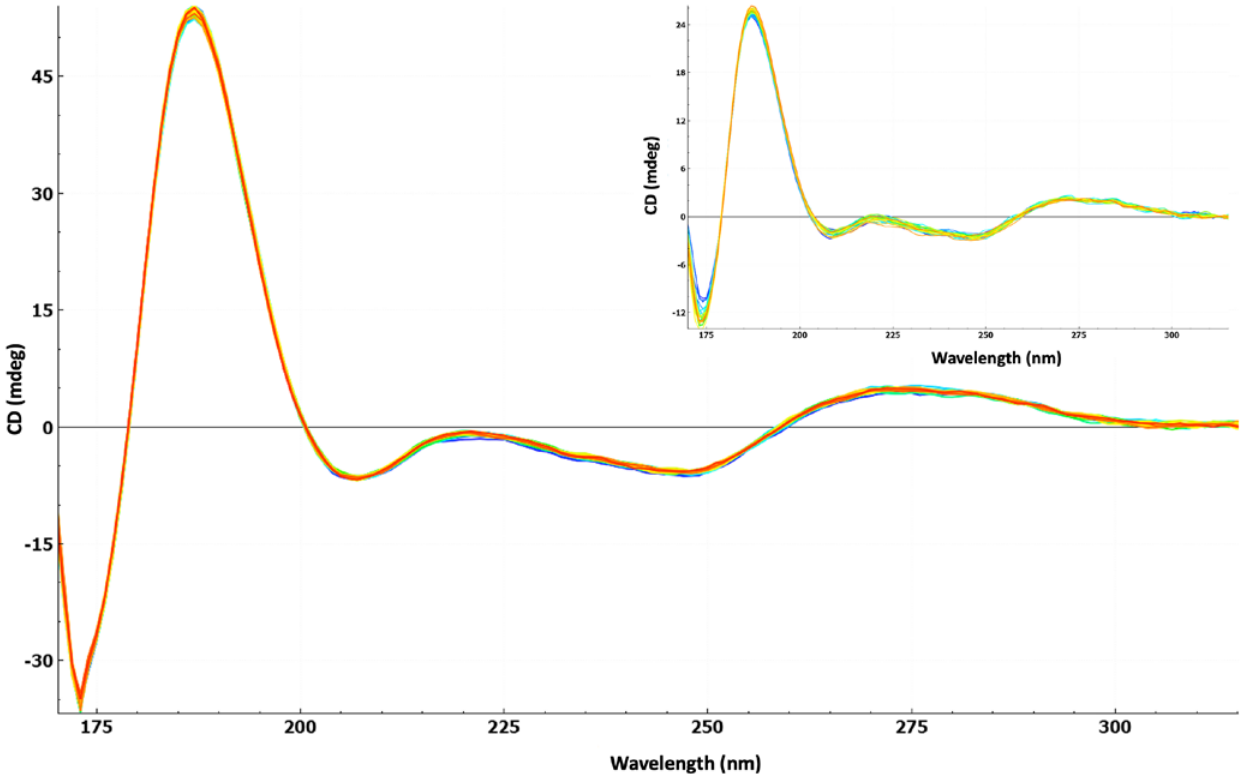
Figure 3. Analysis of dsDNA ColE1 origin melting by Hfq-CTR using SRCD. Spectra of the kinetics are from blue (taken 2 min after the addition of the CTR) to red (80 min after the addition of the CTR). Inset: control with full-length Hfq protein. As shown, the structure does not change, indicating that neither Hfq nor Hfq-CTR can melt dsDNA ColE1 origin.